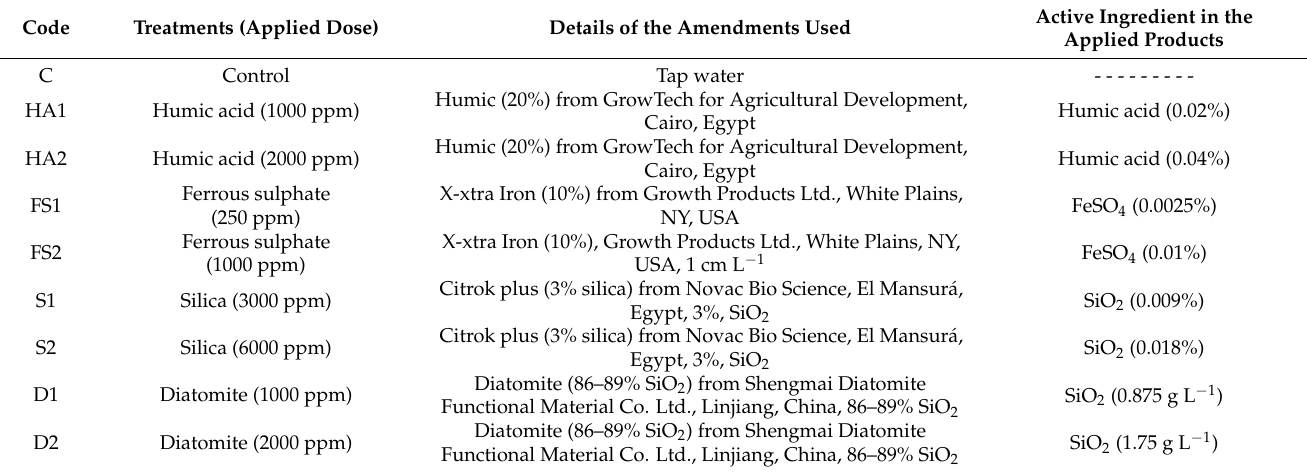
Table 1. Overview of the different treatments and their applied doses.